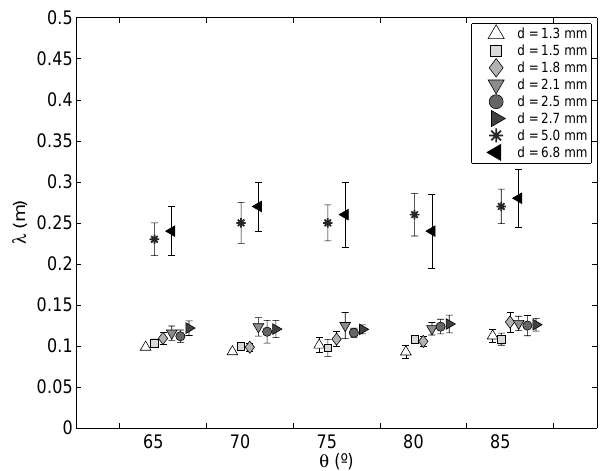
Fig. 9. Current head height ( h ) versus slope angle ( θ ) for currents consisting of 1.8mm and 6.8mm diameter EPS beads. Head height was measured at a distance of 1m from the line release. Error bars have length equal to the standard deviation from the mean.